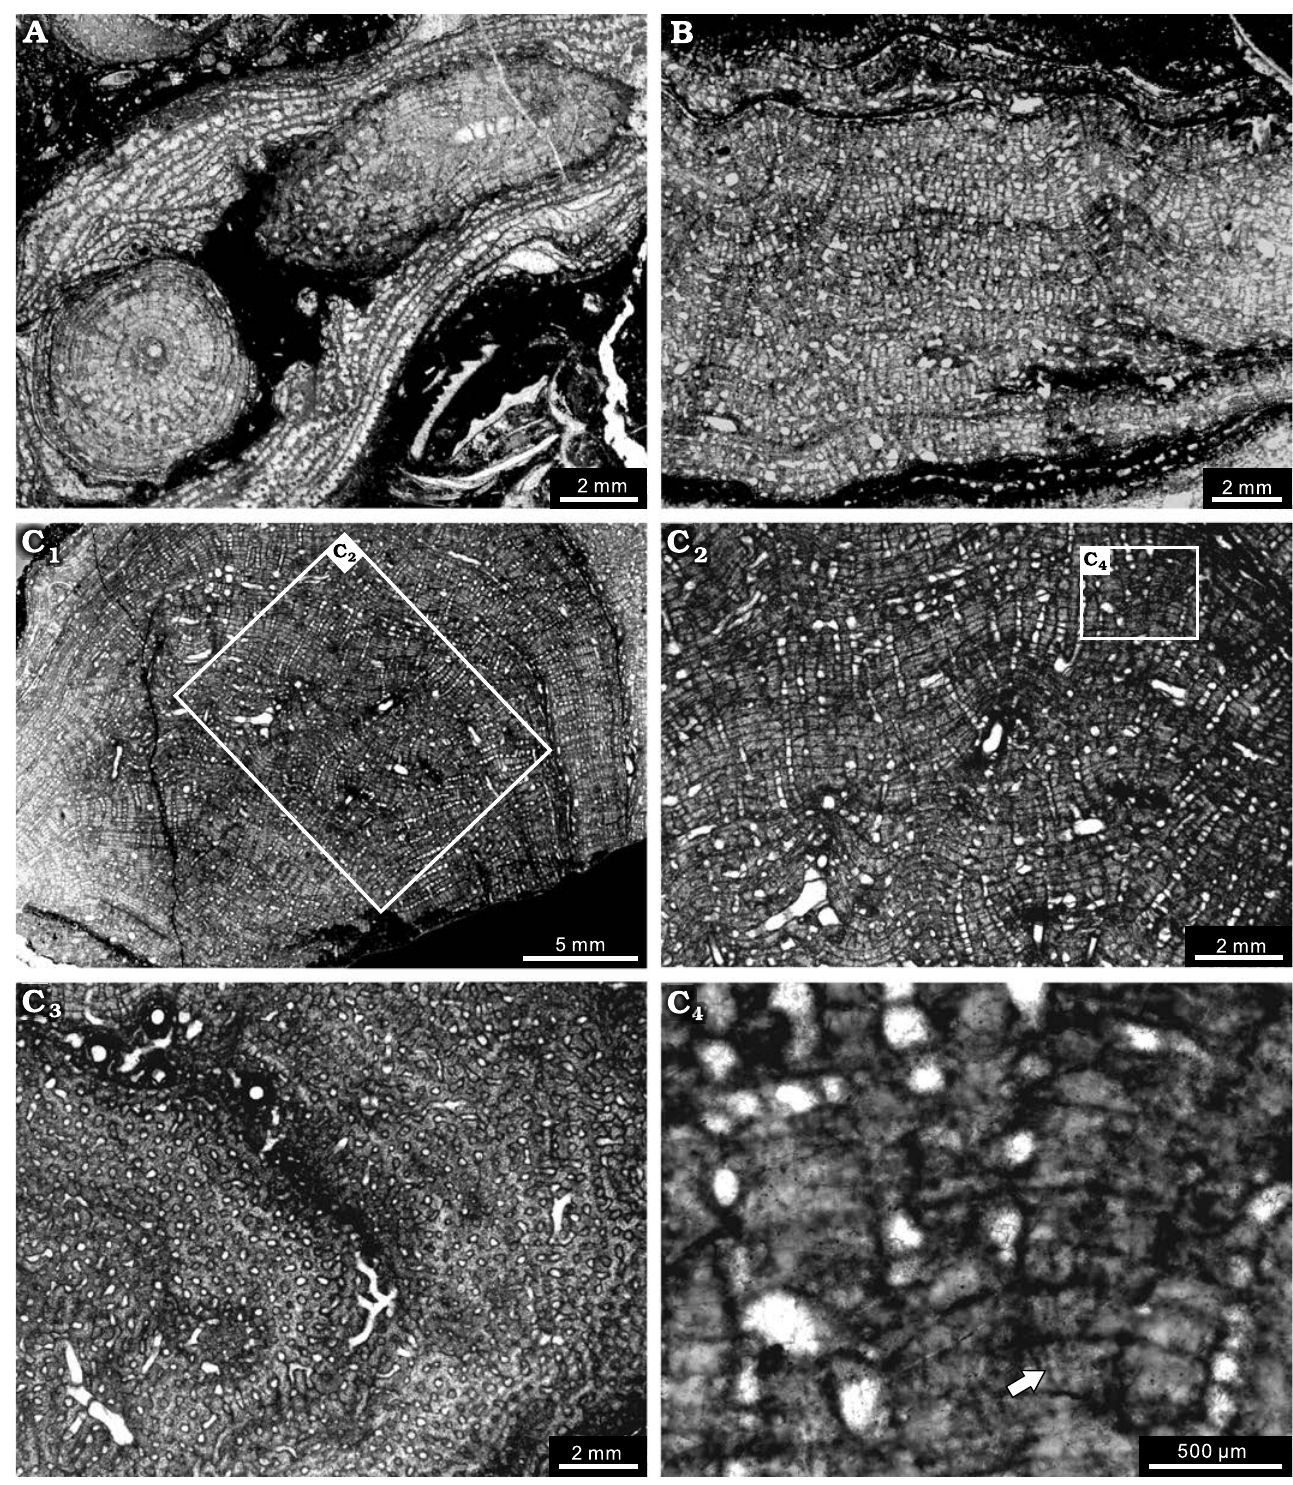
Fig. 11. Stromatoporoid Stachyodes fasciculata Dong in Dong et al., 1989, from the Jiwozhai reef, Jiwozhai Member, Dushan Formation, Givetian, Middle Devonian; Dushan, Guizhou, South China. A . NIGP 177060; longitudinal section and tangential section of the dendroid form. B . NIGP 177061; longitudinal section showing the thick pachysteles and thin pachystromes. C . NIGP 177062; C 1 , longitudinal section of the bulbous form; C 2 , enlarge- ment of C 1 , illustrating regu lar skeleton; C 3 , tangential section showing the autotubes and astrorhizal canals; C 4 , enlargement of C 2 , showing the coarsely striated microstructure